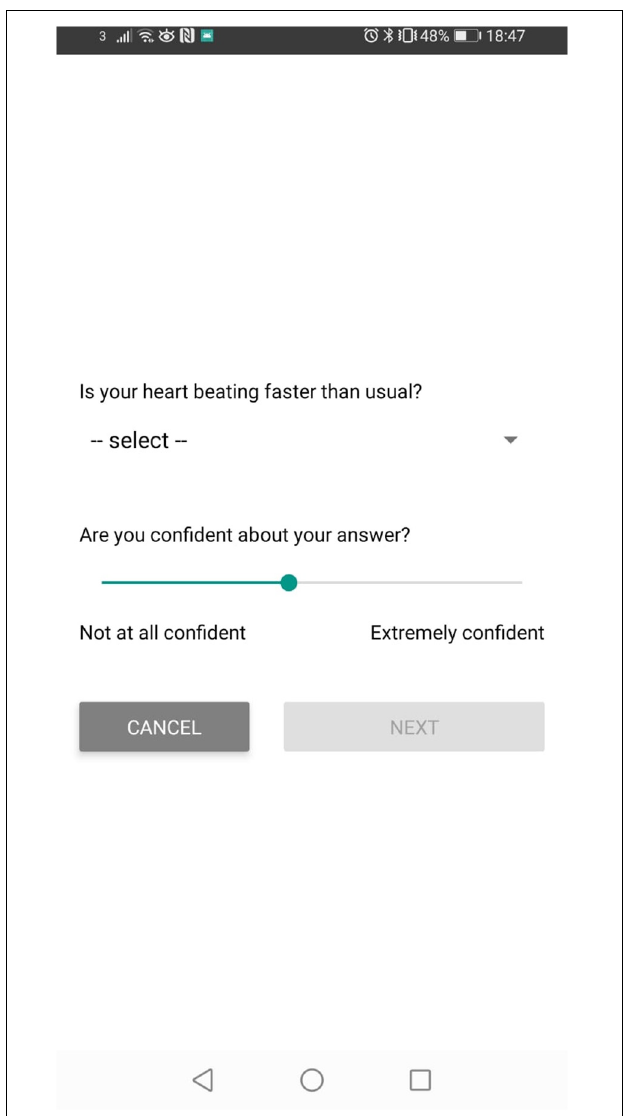
FIGURE 1 | Example of a question screen comprising the heart rate judgment and the confidence rating. Following this screen, participants were presented with a free text box and asked to report what they were doing in the 30 min preceding the